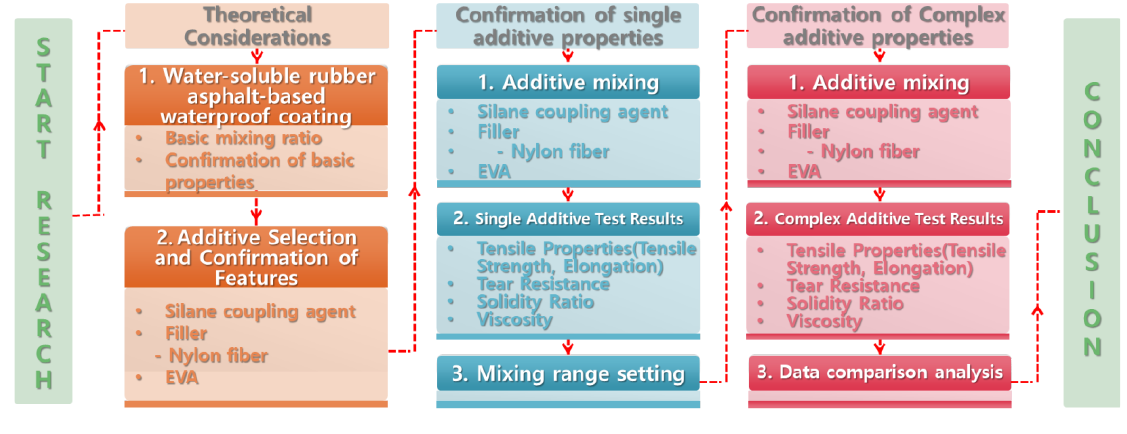
Figure 8. Research flow chart.